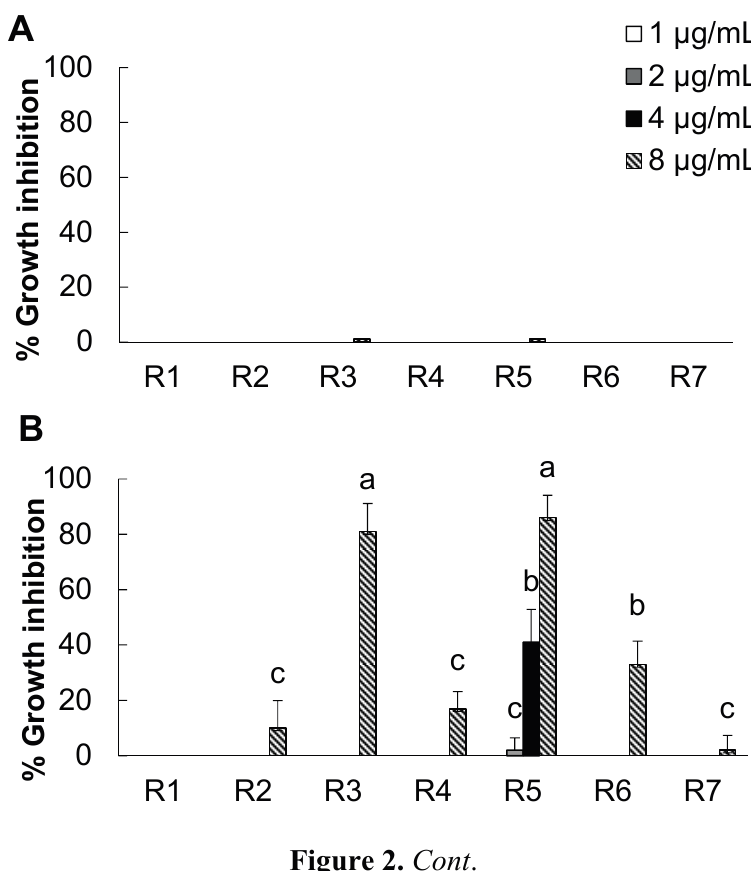
Figure 1. Chemical structure of the selected natural compounds in Robinia pseudoacacia.